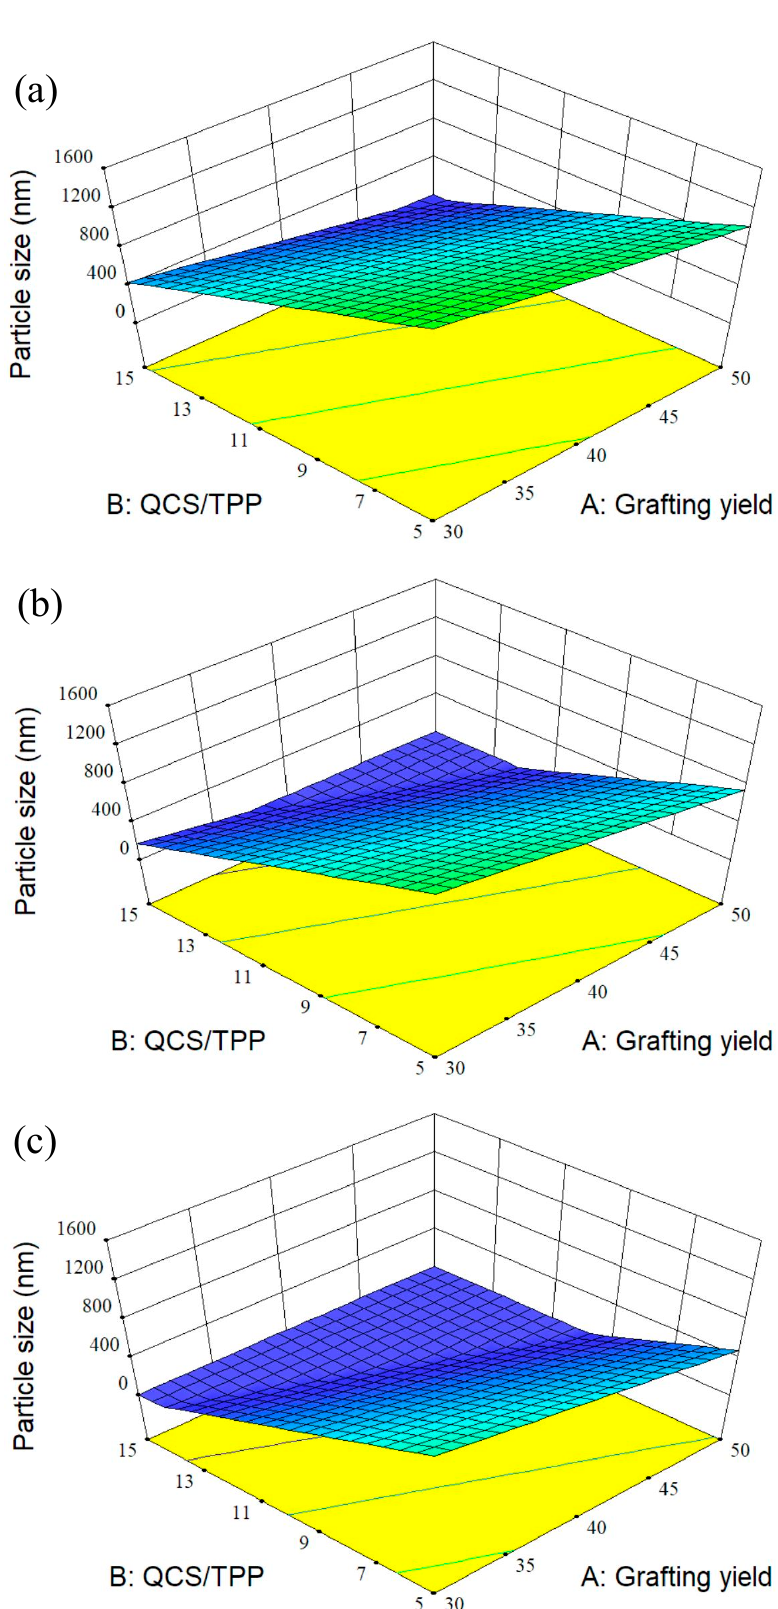
Figure 4. 3D response surface plots showing the effects of grafting yield and weight ratio of QCS/TPP at different weight ratios of QCS/genipin of ( a ) 20/1, ( b ) 40/1, and ( c ) 60/1 on particle size.